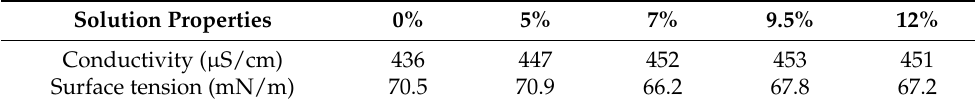
Table 2. Values of conductivity and surface tension for solutions with nanoparticles of